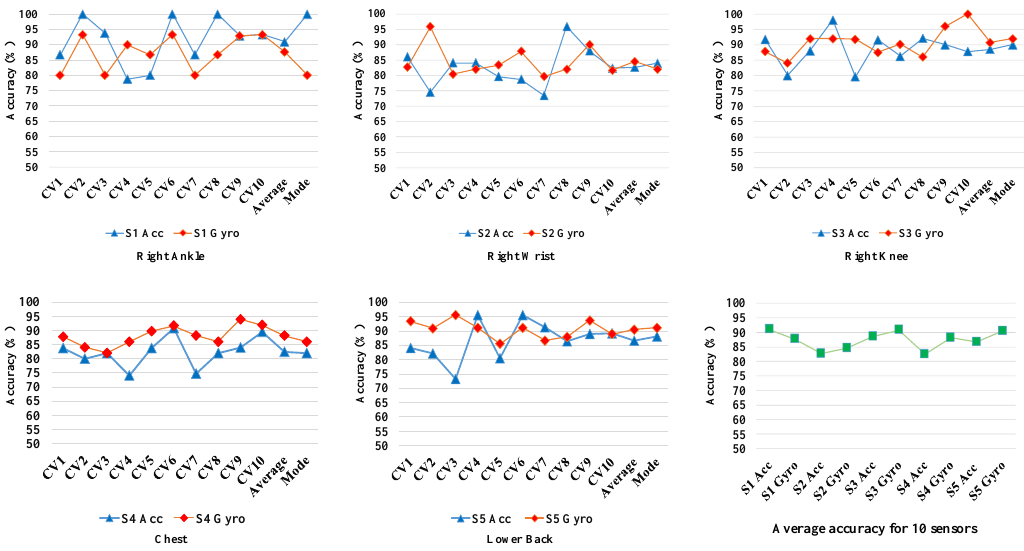
Figure 11. 10 Cross Validation Performance of the Individual Sensors Including Both Gyroscope (Gyro) and Accelerometer (Acc) sensors. CV j indicates Cross-Validation j , and S i indicates sensor i .